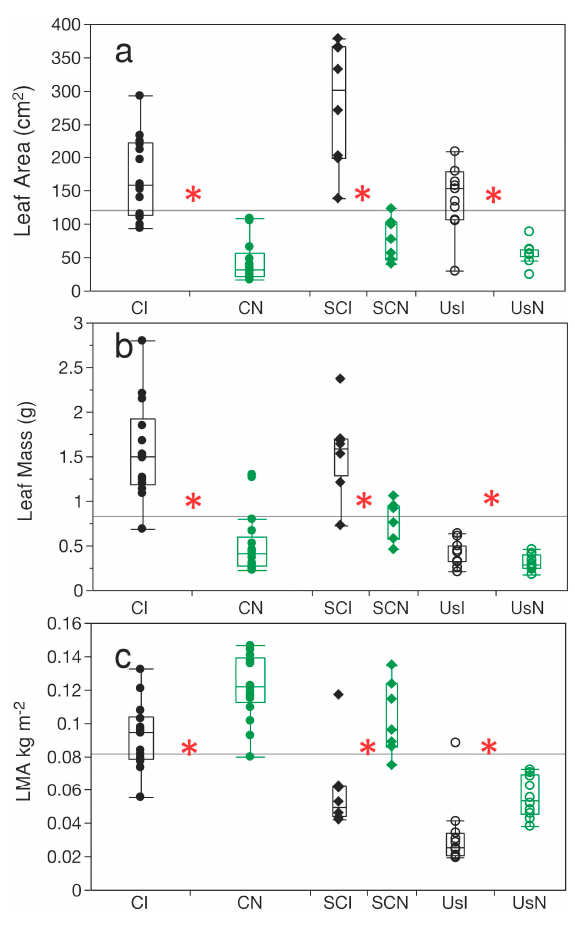
Figure 2. ( a ) Leaf area; ( b ) leaf mass and ( c ) leaf mass per area (LMA) of C. elastica (I) (black symbols) and group of native species (N) (green symbols) measured in the canopy (C), subcanopy (SC), and understory (Us) of a Castilla novel forest. Number of samples: CI = 14, CN = 16, SCI = 8, SCN = 7, UsI = 11, UsN = 10. The red asterisks indicate significant differences between groups within each stratum (Wilcoxon z, p < 0.01).